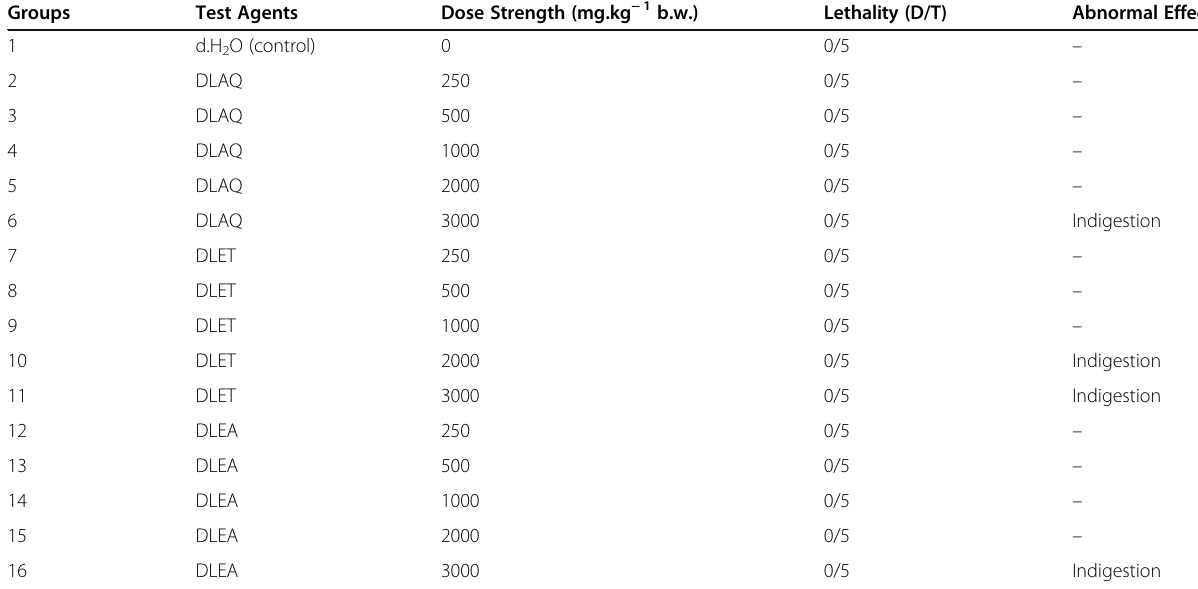
Table 1 Acute Toxicity Study Report of D. linearis leaf extract Groups